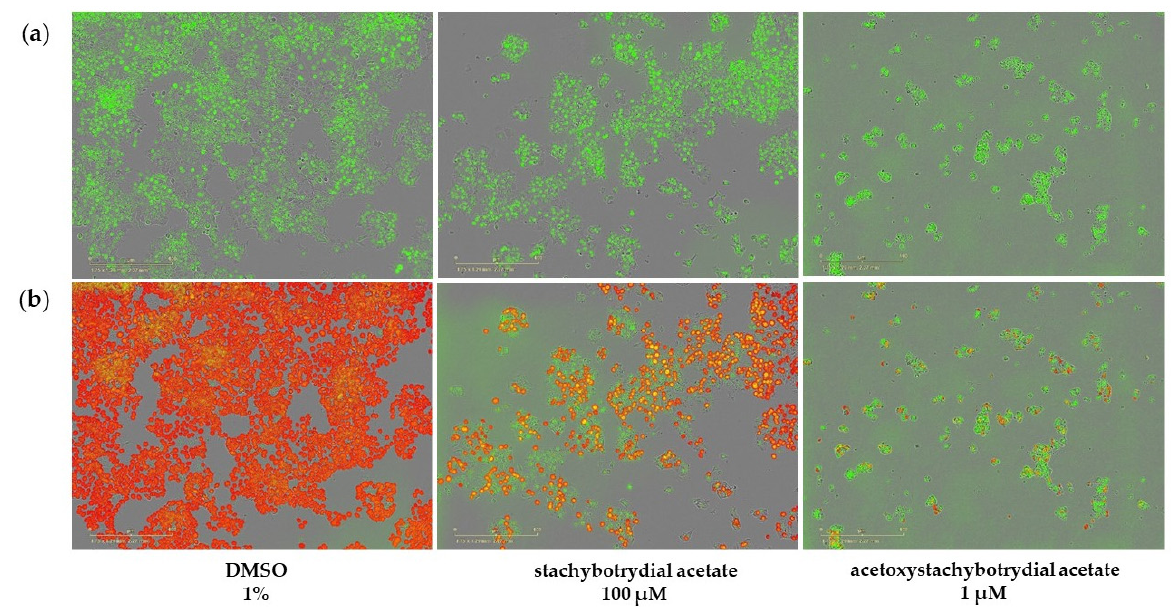
Figure 6. Fluorescence images of MCF7 NucLight green cells treated with 1% DMSO, 100 µM stachybotrydial acetate or 1 µM acetoxystachybotrydial acetate for 24 h. ( a ) Detection of cells by their green fluorescent nuclei. ( b ) Proliferating cells were detected by an additional staining of cell nuclei by the EdU assay using 5-TAMRA-PEG3-azide as a coupled fluorophore. Thus, proliferating cells were monitored by red fluorescence. The pictures in lane ( b ) are an overlay of the green fluorescence images of MCF7 NucLight green and the red fluorescence images showing TAMRA-labeled proliferating cells. Cells that are emitting only green fluorescence are not proliferating, in contrast to those emitting an additional red fluorescence. Images were taken at tenfold magnification on IncuCyte ® live cell imager.